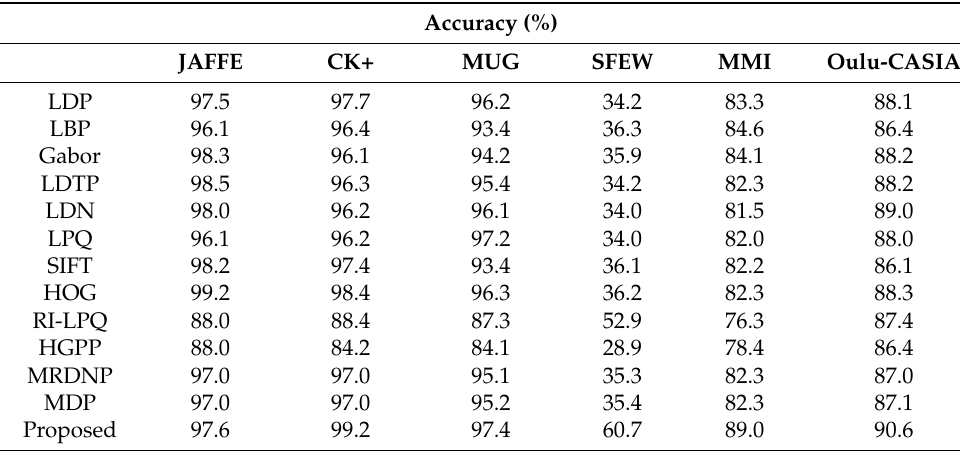
Table 8. Accuracy obtained by different feature